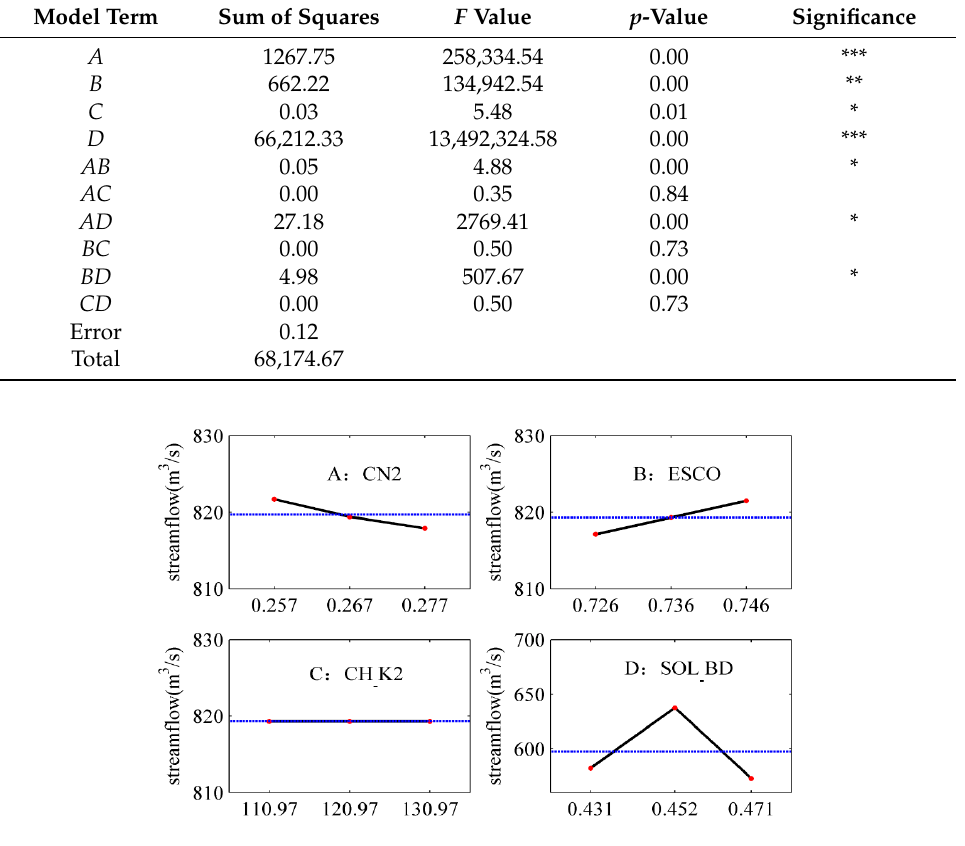
Figure 12. Individual effects of parameters in the post-flood period.